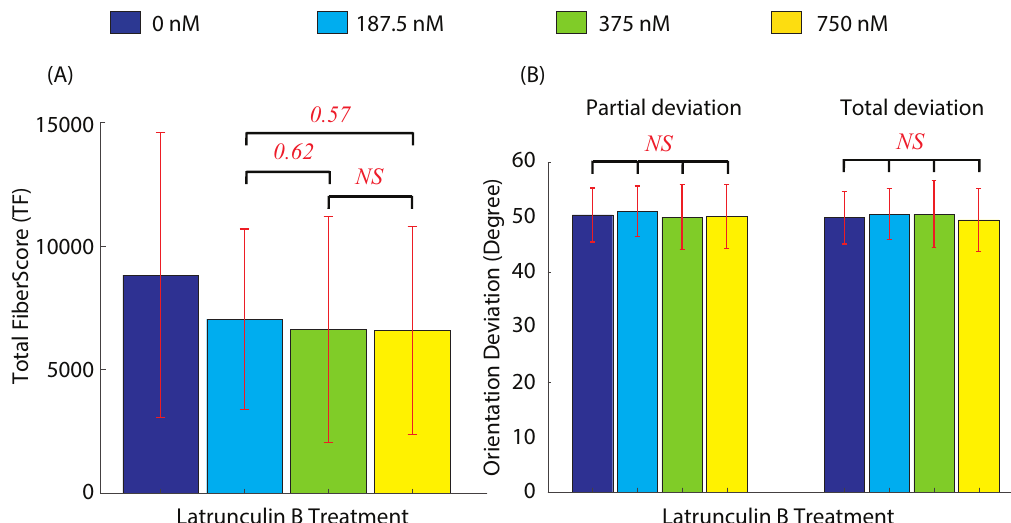
Figure 10. The FiberScore algorithm quantification result for each latrunculin B treatment condition: ( A ) total FiberScore (TF); ( B ) partial deviation (PD) and total deviation (TD). For the untreated cells, TF = 8800 ± 5800, PD = 50 ± 5, and TD = 50 ± 5, and the treated cells have TF = 7000 ± 3700, PD = 51 ± 5, and TD = 51 ± 5, TF = 6600 ± 4600, PD = 51 ± 6, and TD = 50 ± 6, and TF = 6600 ± 4200, PD = 50 ± 6, and TD = 50 ± 6 for the treatment concentrations of 187.5 nM, 375 nM, and 750 nM, respectively. n = 50. Student’s t -test was performed to analyze the statistical difference: the quantification results obtained from each treatment condition were compared with respect to that from the other three treatments, respectively. A p < 0.05 was yielded for each comparison, unless otherwise denoted in the figure (with p -values in red italic font). NS: not